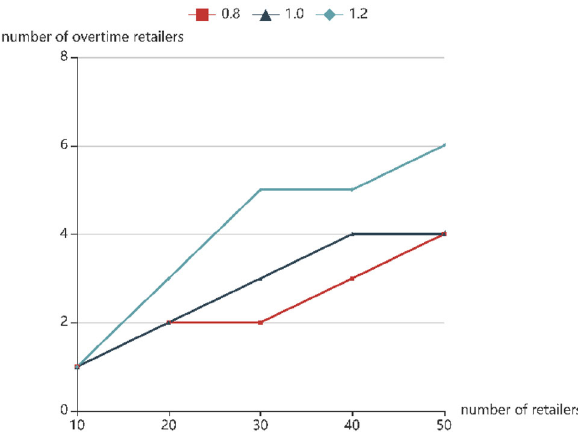
Fig. 9 The number of retailers that violate time window constraints